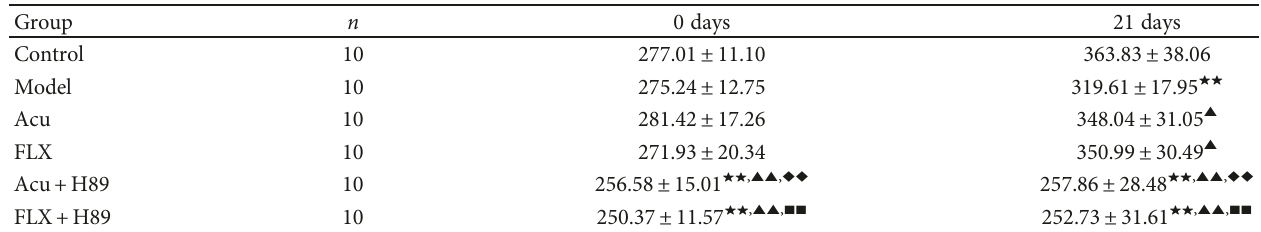
Table 2: Di ff erences showing the e ff ects of stress/antidepressant treatments on depressive-like behaviors in depression rats induced by CUMS. (a) Di ff erences in body weight following stress/antidepressant treatments